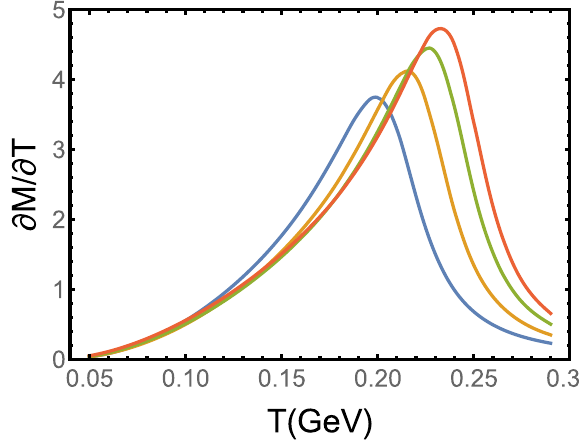
Fig. 3 Chiral susceptibility as functions of temperature at ω = 0 . 1 , 0 . 2 , 0 . 3 , 0 . 4 GeV (from left to right)